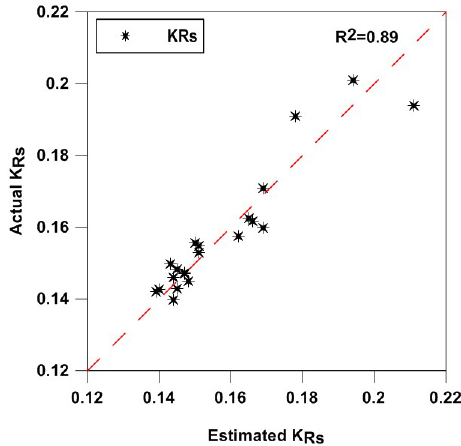
Figure 3. Actual value of K Rs for each station compared with the results of Equation (13). Table 1. Statistical analysis for comparison of daily observed and calculated solar-radiation data for 21 stations of South Korea (SK). Station Code